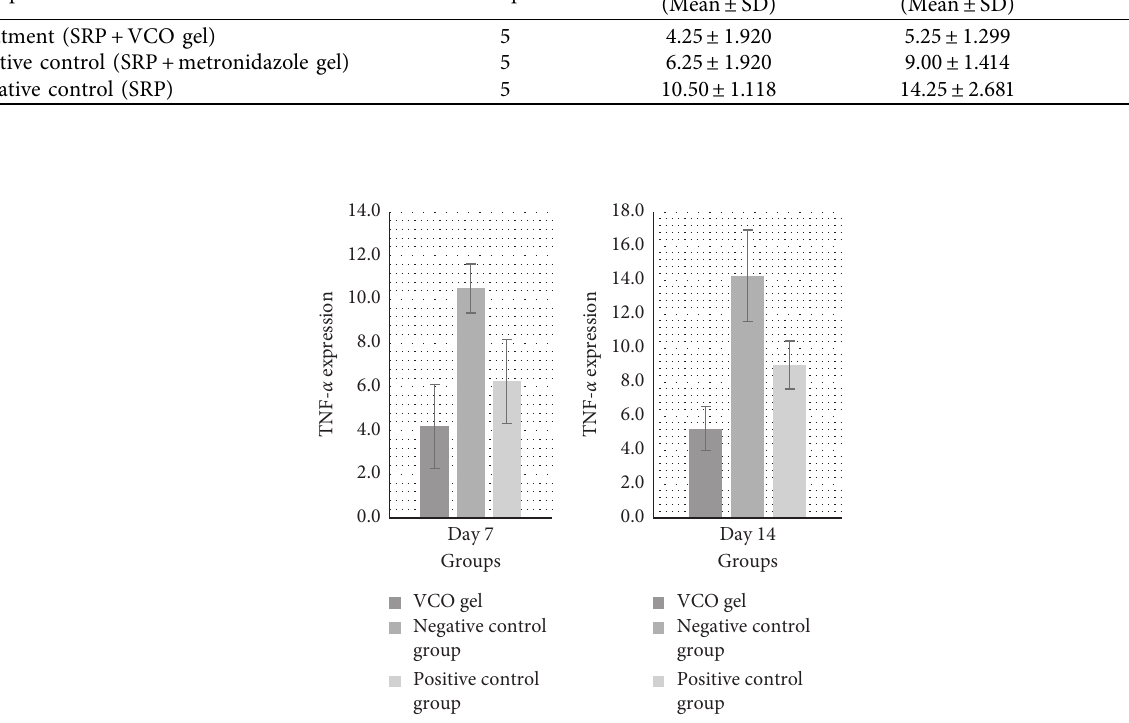
Figure 1: Bar charts indicating TNF- α expression on the 7th and 14th day.